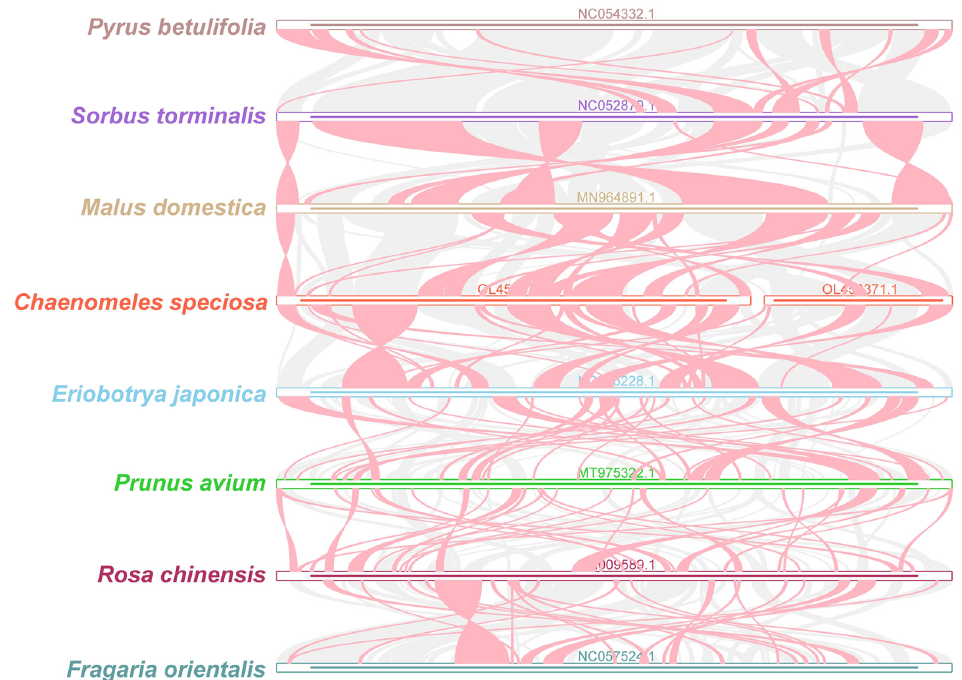
Figure 7. Pairwise mitochondrial genome synteny analysis of seven species of Rosaceae. The bars indicate the mitochondrial genomes, and the ribbons show the homologous sequences between adjacent species. The red areas indicate where the inversion occurred, and the gray areas indicate regions of high homology. The regions with no colinear blocks are indicated as unique in the species.